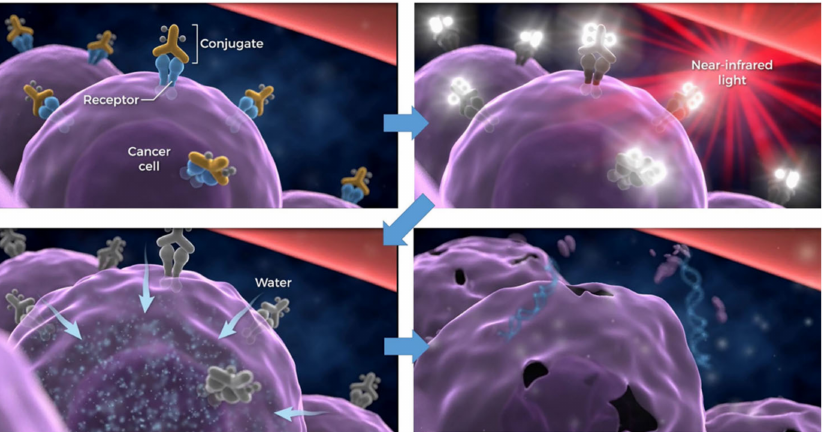
Figure 1. Scheme for cellular cytotoxicity induced by NIR-PIT. Antibody-photoabsorber conjugates bind to a specific cell membrane antigen. Immediately after NIR light exposure to APC, the water outside of the cells is flown into the target cell, leading to cell death. Adapted from Ref